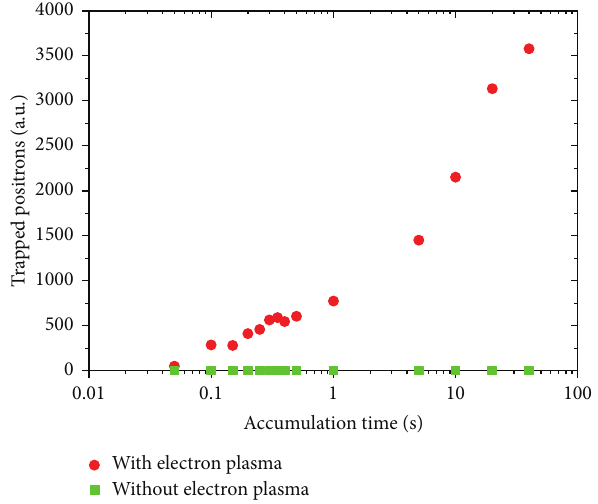
Figure 2: The accumulation of positrons (from [30]).